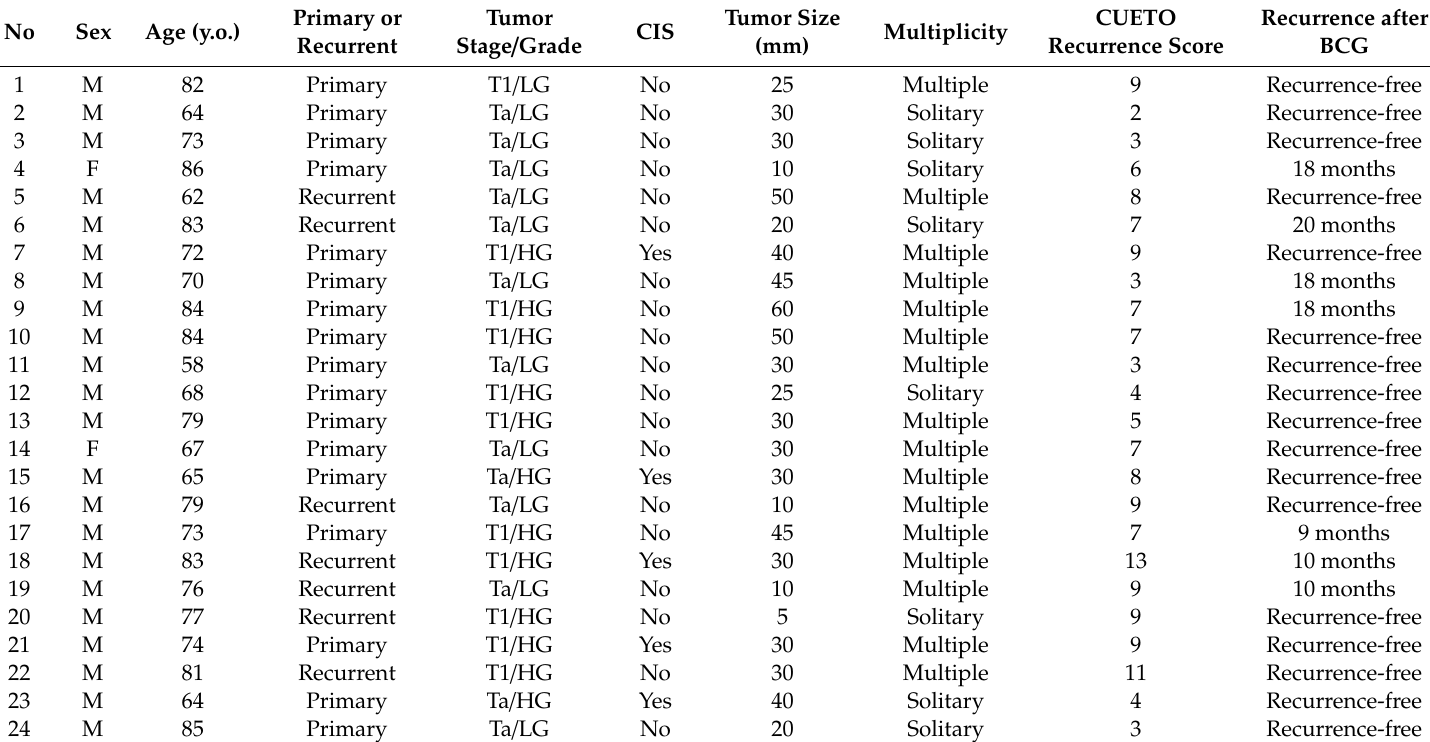
Table 1. Clinicopathological characteristics of 24 patients enrolled in this